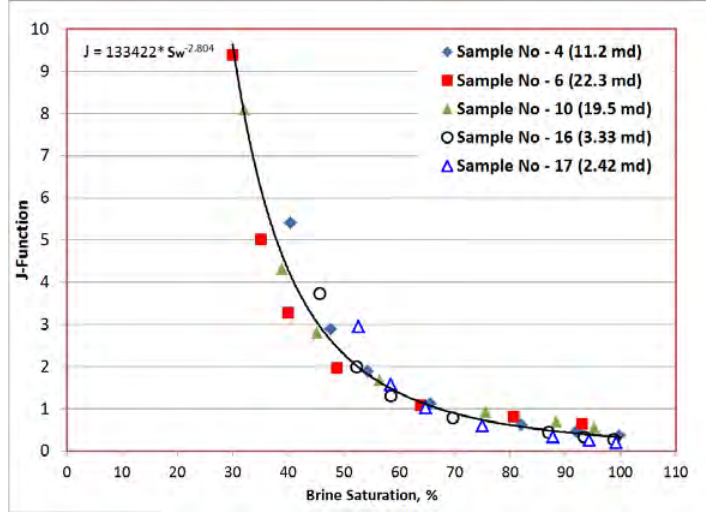
Figure 13. Leverett J-Functionfor the Upper Bahariya reservoir core